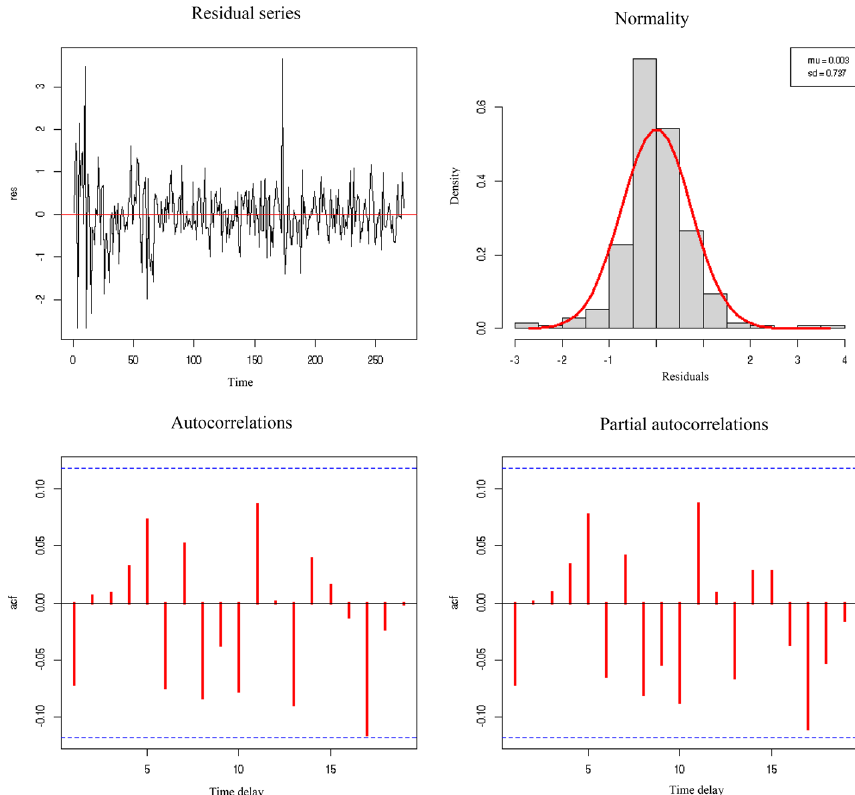
Fig. 9 Residual series, normality, and autocorrelations of abnormal stock prices in the tourist sector against the variable cumulative number of COVID‑19 cases. Source : Authors’